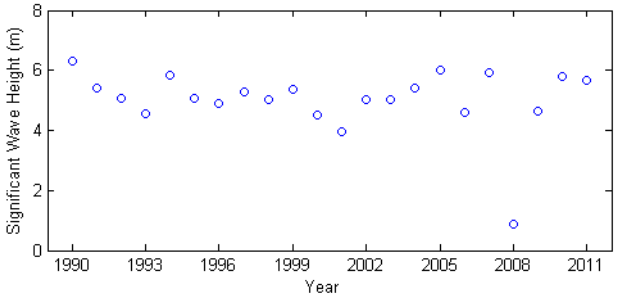
Figure 10. Extreme samples extracted by the annual maxima (AM) method at location S1.